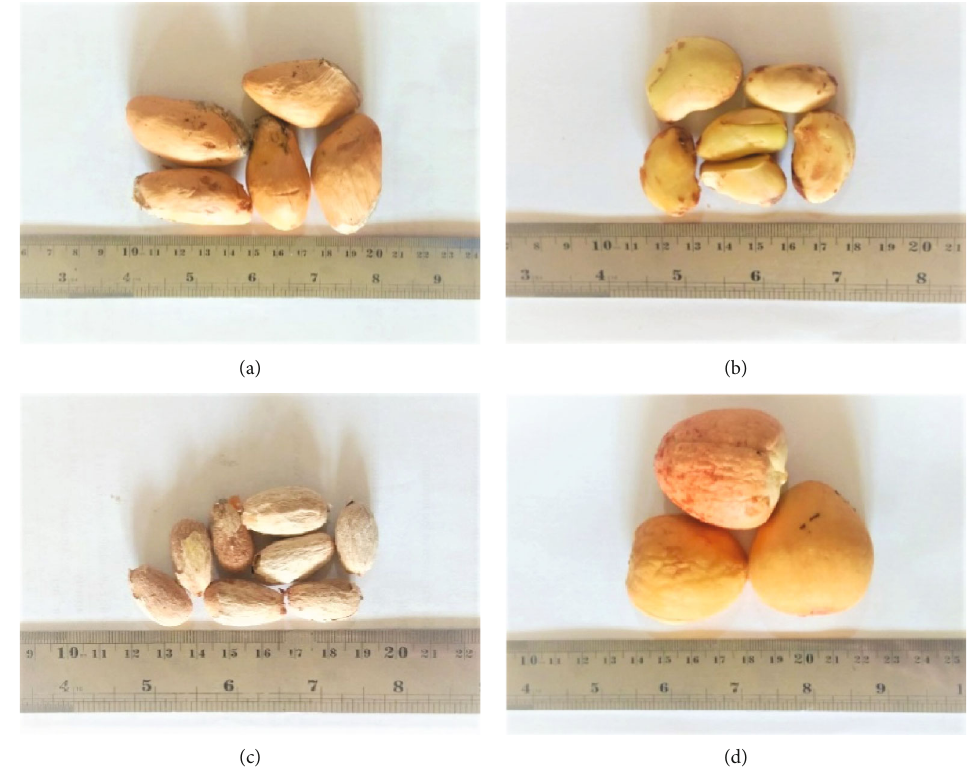
Figure 2: Fruit seed kernels: (a) durian, (b) jackfruit, (c) rambutan, and (d)